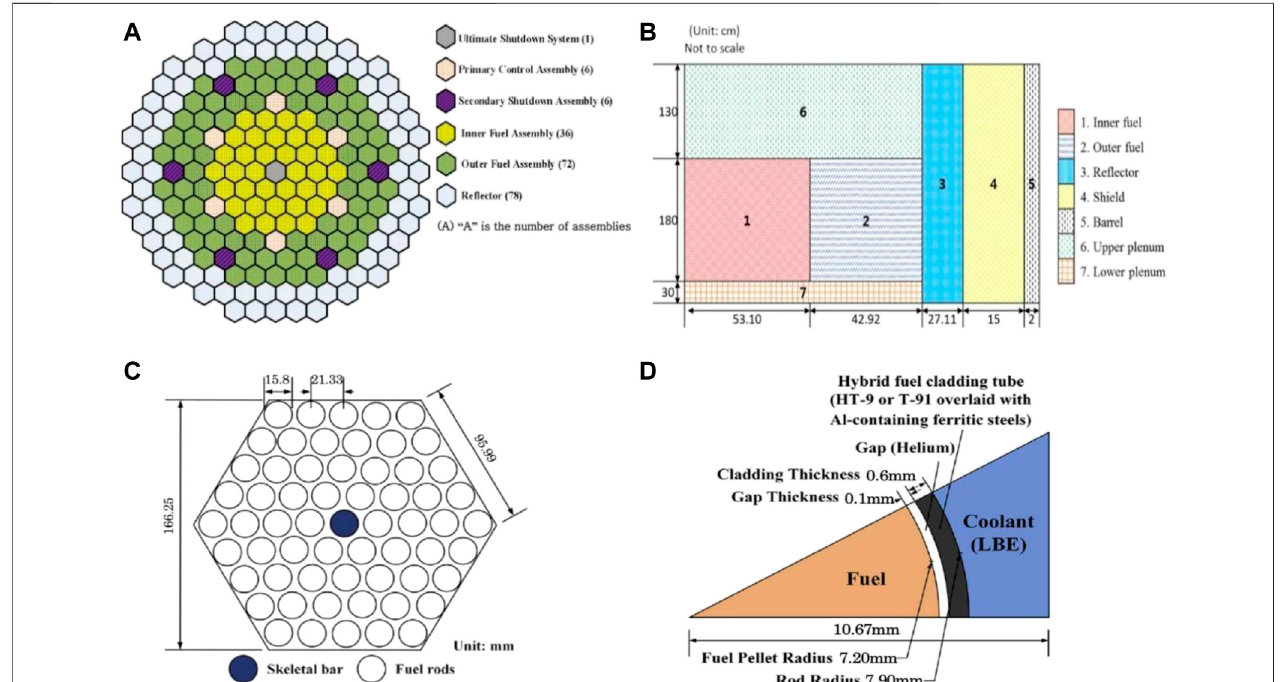
FIGURE 5 | Original core (A,B) , fuel assembly (C) , and fuel rod (D) of URANUS.